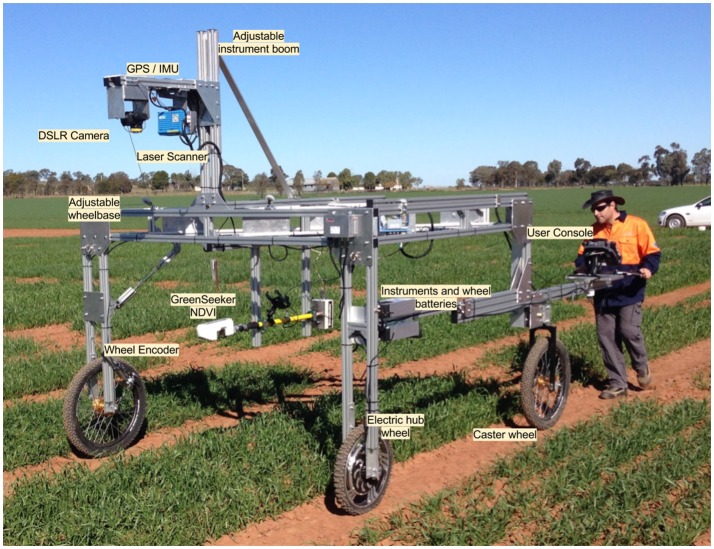
Phenomobile Lite comprising LiDAR laser scanner, digital single-lens reflex (DSLR) camera, GreenSeeker and touch-screen computer mounted on an aluminum frame with adjustable wheel spacing to accommodate different plot widths (1.75–2.20 m) and ground-clearance for canopy heights up to 1.5 m. The height adjustable sensor boom (2.0–2.5 m) enables data capture from crop emergence to maturity. The Phenomobile Lite is powered by an electric wheel and steered by an operator walking behind. Data is captured on a touch screen computer and processed through a web interface whereby the user processes the plot data in a semi-automated fashion (see Figures 2, 3).